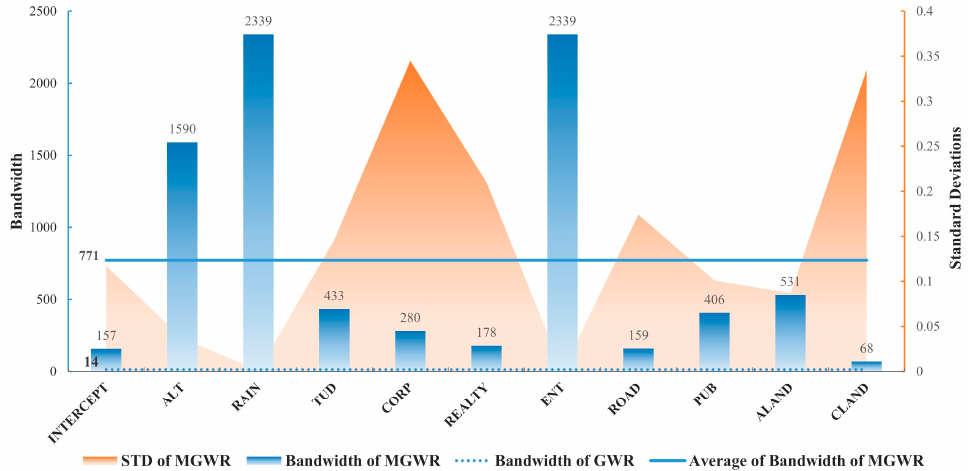
Figure 6. Optimal bandwidths generated by MGWR and GWR and standard deviations of parameter estimates of MGWR.